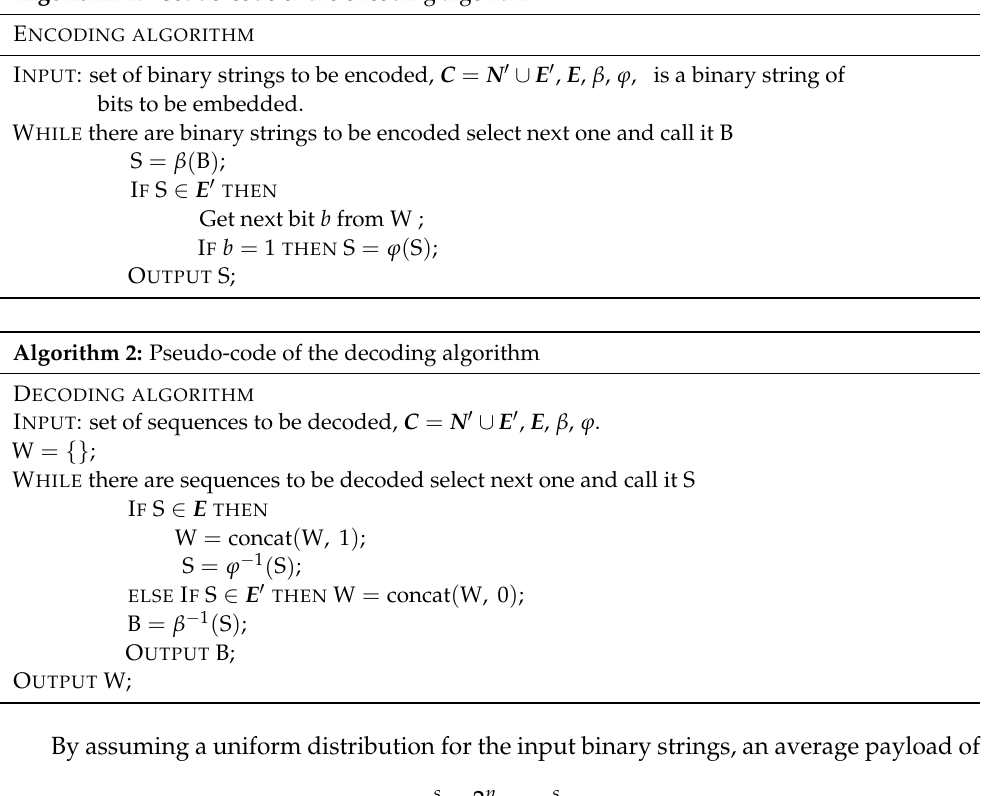
Algorithm 1: Pseudo-code of the encoding algorithm E NCODING ALGORITHM